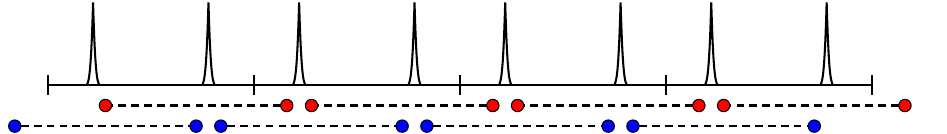
FIG. 15. A cartoon of the entanglement pattern for q ¼ 4 with a periodic boundary condition. Red and blue stand for two different chiralities. Each peak is entangled with its nearest neighbor with the same chirality or